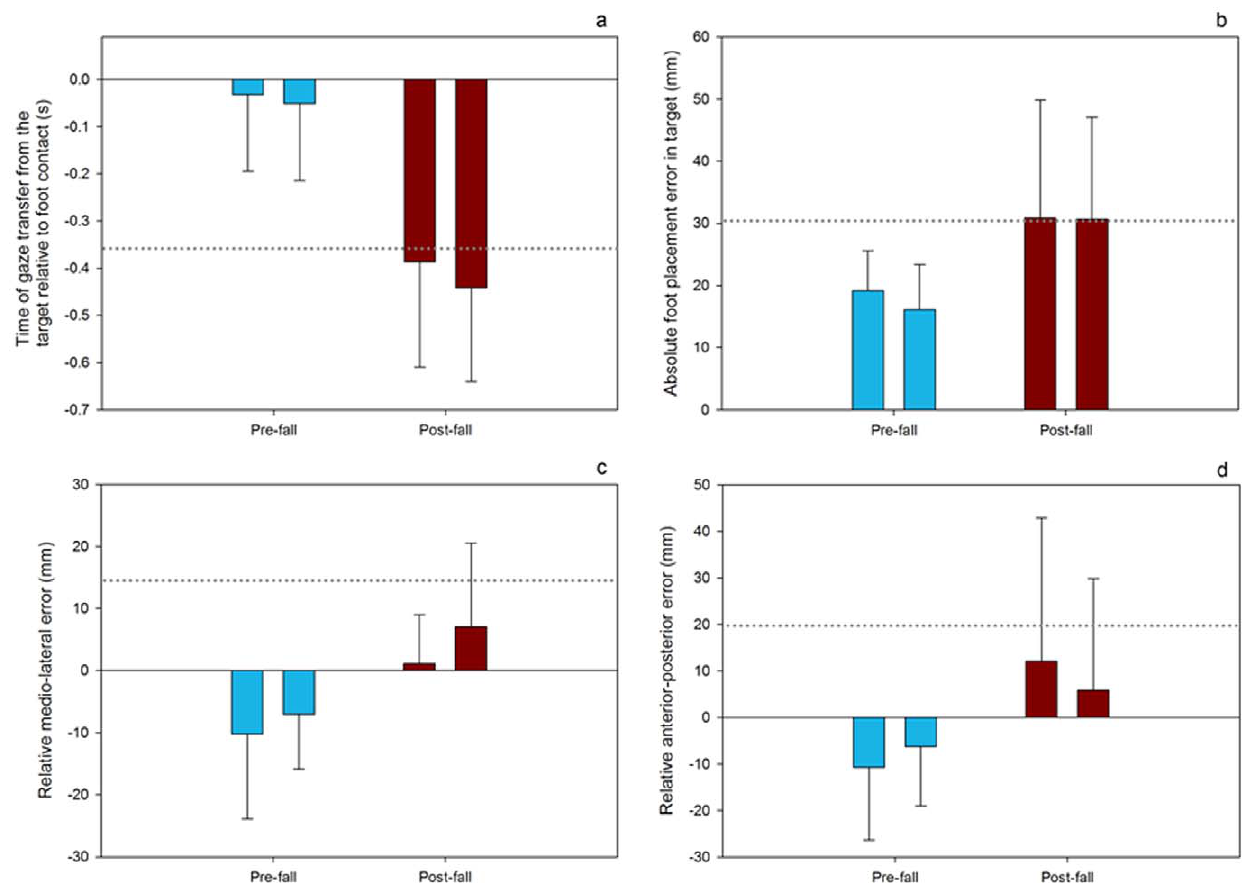
Figure 2. All plots represent mean values for both pre- and post-fall sessions. a) time of gaze transfer from the stepping guide, b) mean absolute error, c) M-L error (where positive values represent a lateral foot placement bias in the stepping guide), d) A-P error (where positive values represent an anterior foot placement bias in the stepping guide). Error bars represent the standard deviations of the mean for each session. Horizontal dotted lines represent 2SD above mean values from all 40 pre-fall trials.